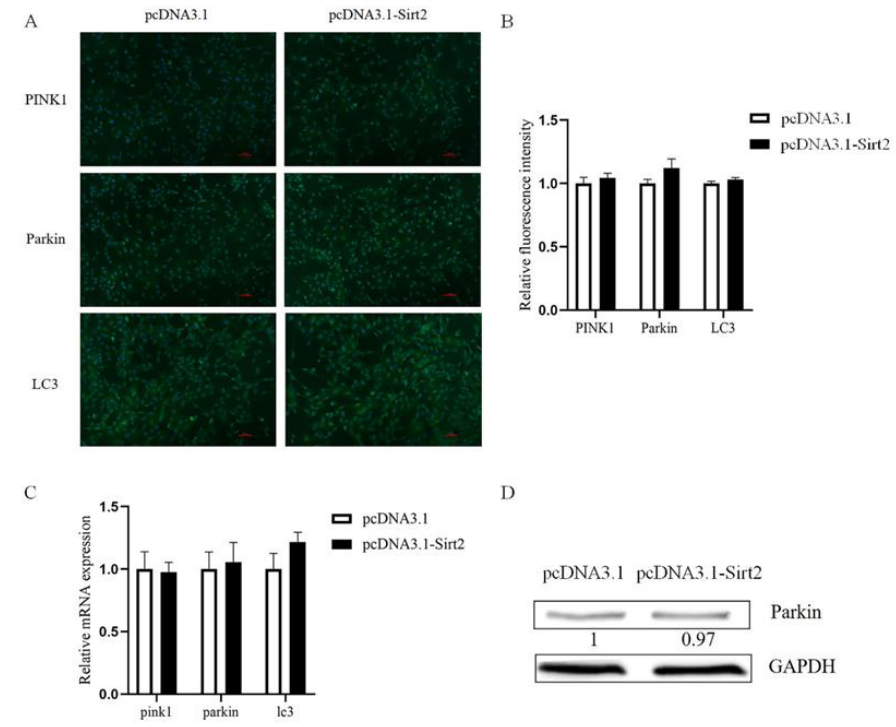
Figure 8. Overexpression of Sirt2 in granulosa cells had no effect on mitophagy. ( A ) Immunofluo- rescence staining images of mitophagy proteins PINK1, Parkin, and LC3 after Sirt2 overexpression. Bar = 100 µ m. ( B ) The relative expression level of mitophagy proteins by immunofluorescence stain- ing after Sirt2 overexpression. ( C ) The mRNA relative expression level of mitophagy genes (pink1, parkin, and lc3) after Sirt2 overexpression was detected by qRT-PCR. ( D ) The protein level of mi- tophagy protein Parkin after Sirt2 overexpression. The graph shows the mean ± SEM of the results obtained in three independent experiments.